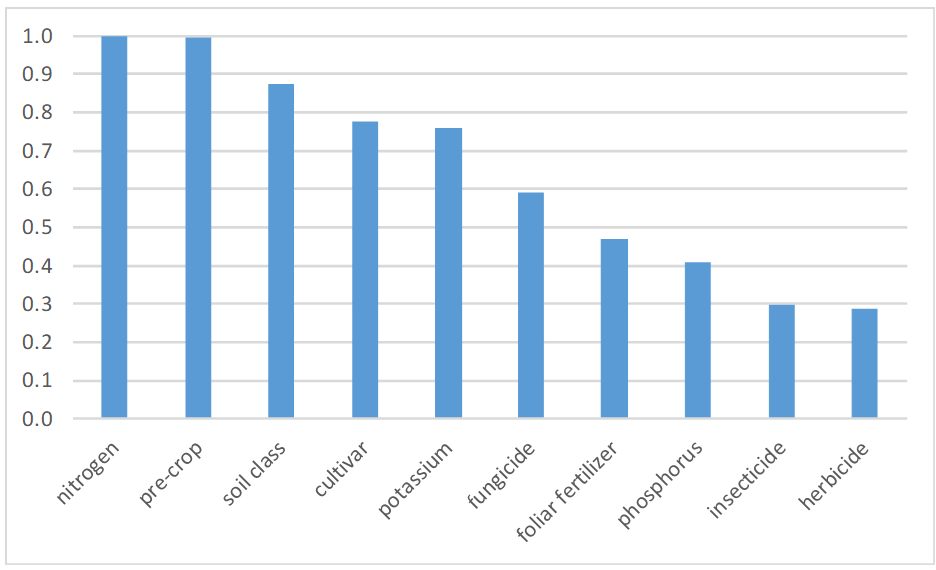
Figure 4. The most important independent variables in the CART tree construction (the closer to 1 the more important variable in the CART tree).